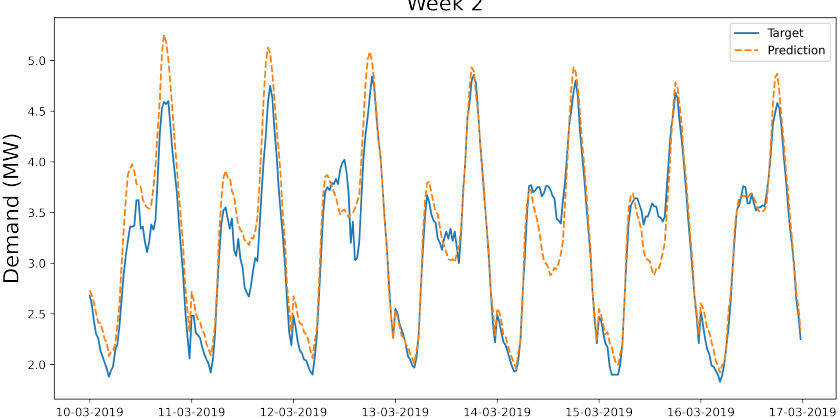
Figure 10. Plot of Catboost model’s predictions for week 2. There are some large errors for the evenings of the fifth and sixth